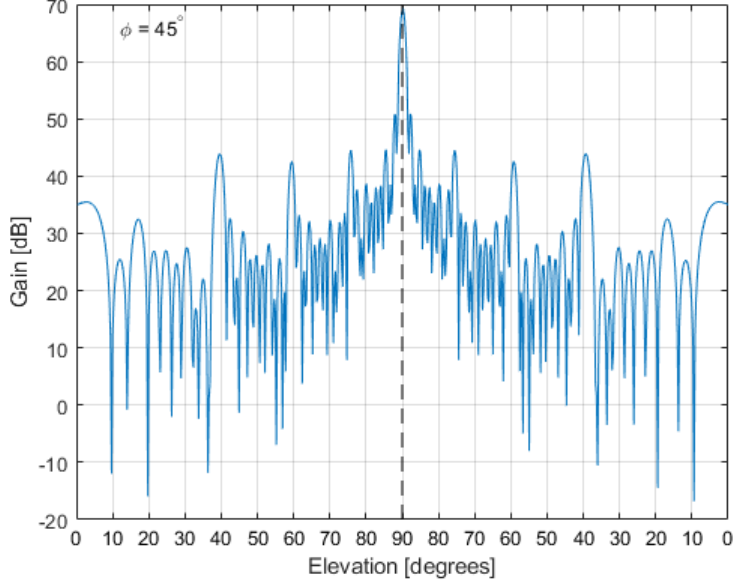
Figure 12. Vertical cut at 45 ◦ azimuth of the unsteered beam pattern of the LOFAR station. A beam pattern of the LOFAR station steered at φ st = 8 ◦ and θ st = 20 ◦ is presented in Figure 13. Figures 14 and 15 show the vertical and horizontal cuts of this beam pattern at 8 ◦ azimuth and at 20 ◦ elevation, respectively (compare to Figures 9 and 10 obtained for the single tile).